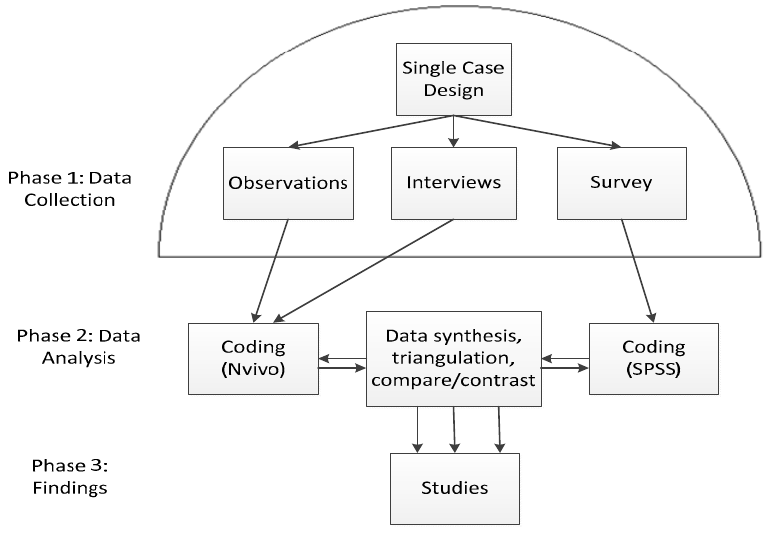
Figure 1. Flow diagram.